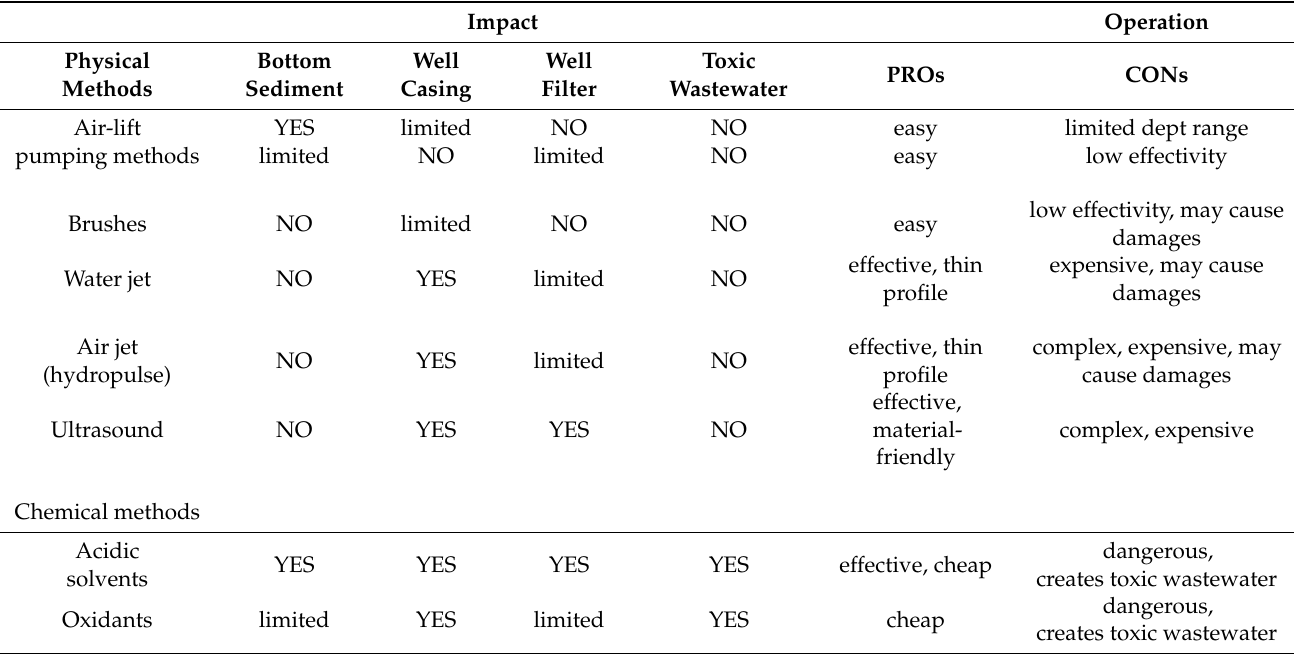
Table 4. Advantages and disadvantages of “ULTRA” solution in comparison to other